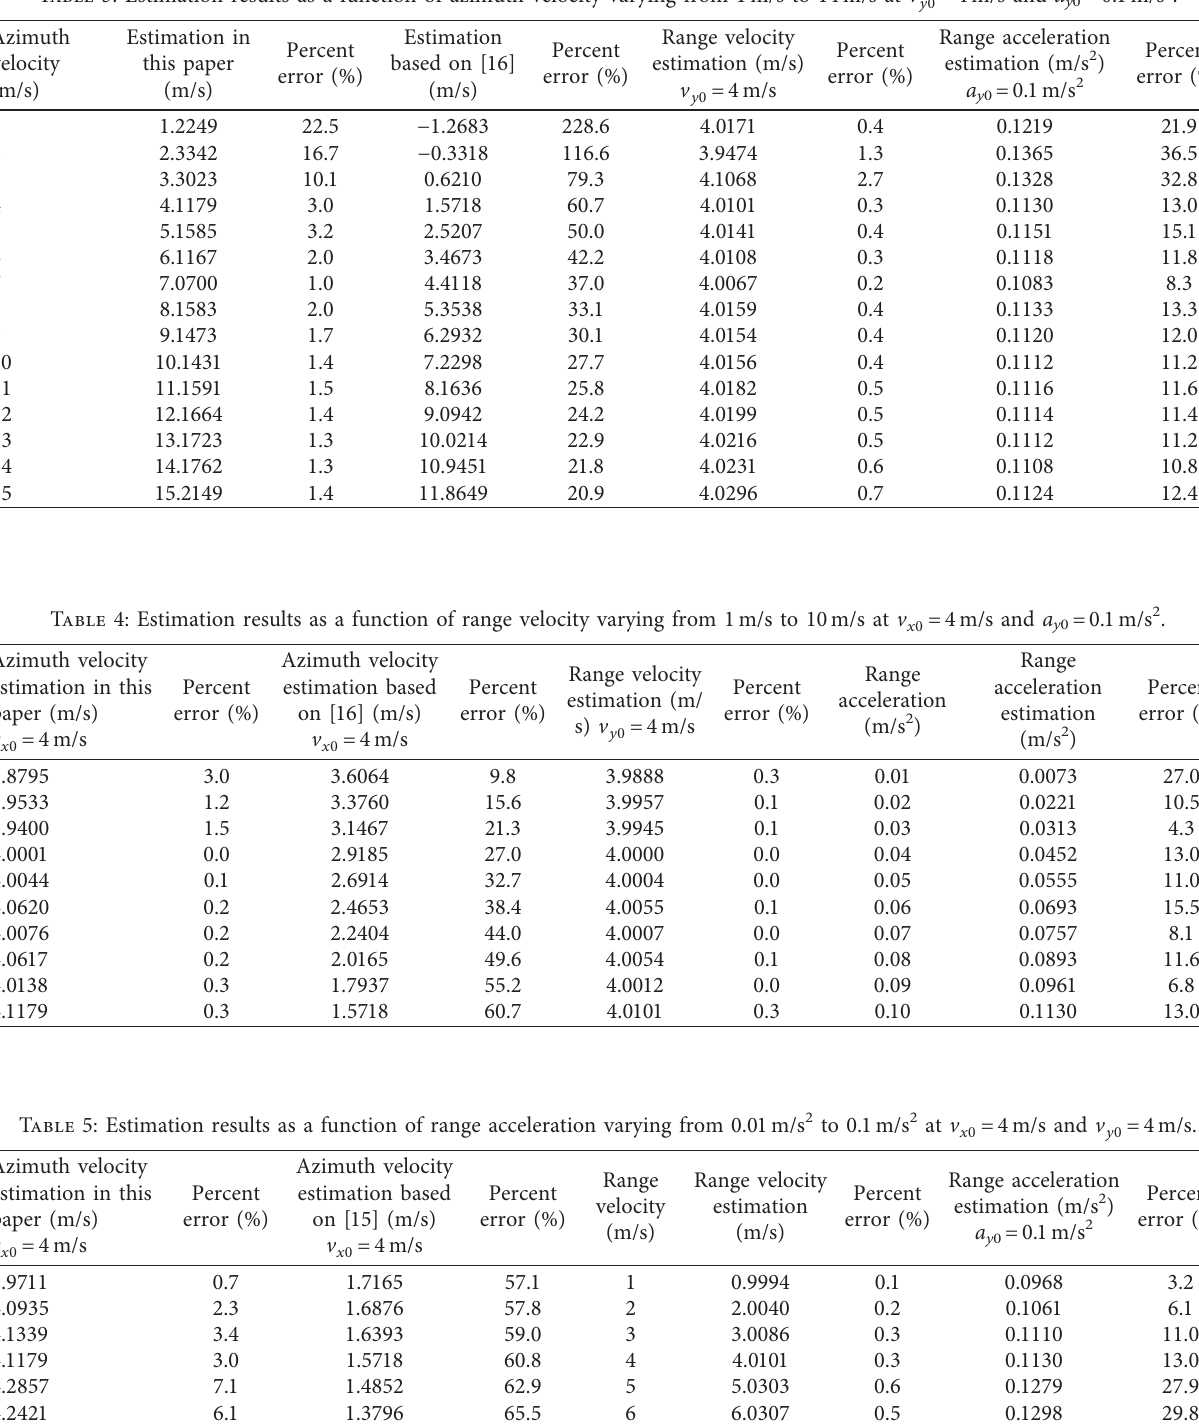
� 4m/s and a � 0.1m/s 2 . y 0 y 0